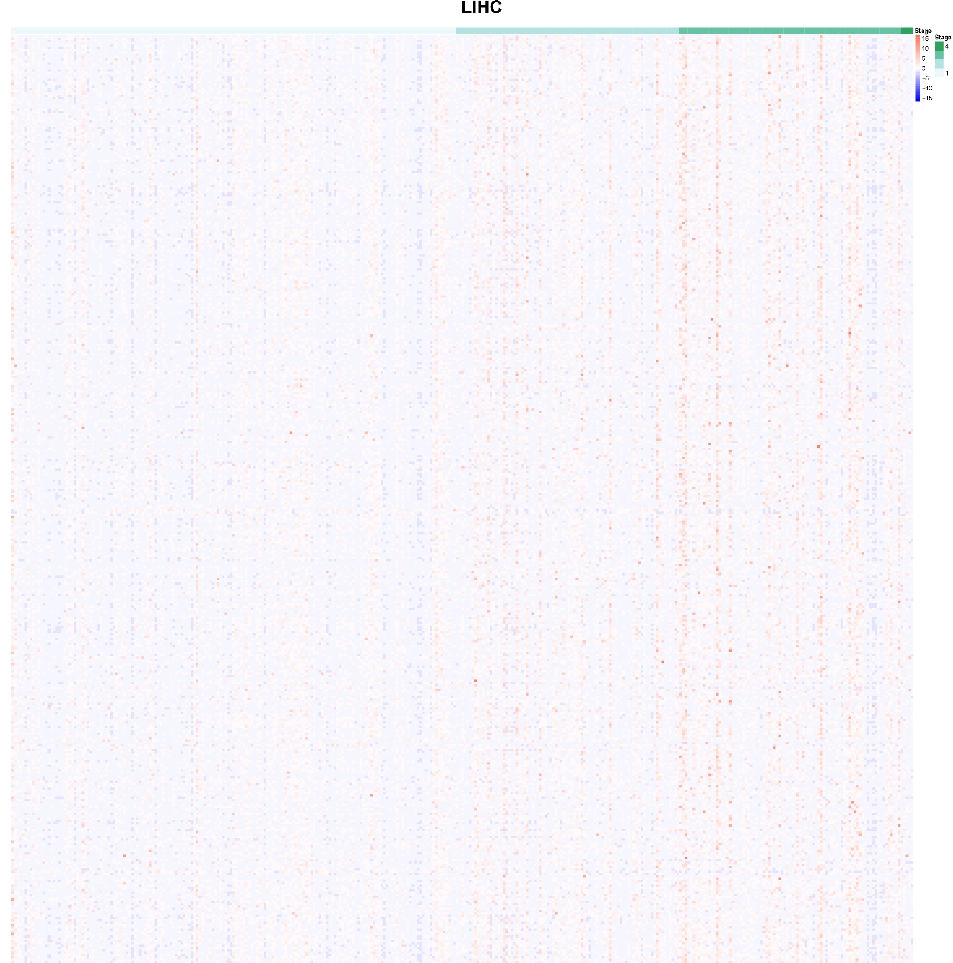
Figure 1. Expression of 405 of m6A RNA methylation-related genes at different stages (I–IV) of liver hepatocellular carcinoma from TCGA dataset. 94